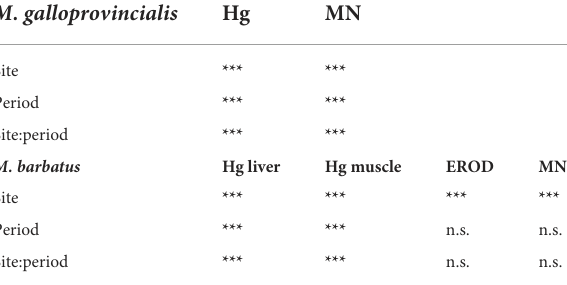
TABLE 6 The two-way analysis of variance results for chemical and biological parameters measured in mussels M. galloprovincialis and red mullet M. barbatus .